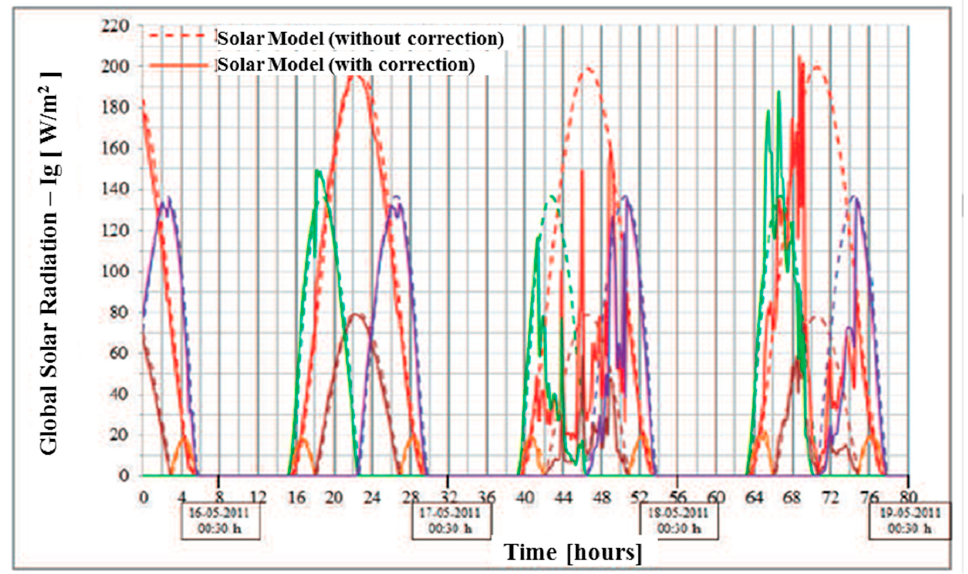
Figure 13. Absorbed radiation, by a white surface ( α s = 0.25), estimated by the solar model for T l = 4.5 and corrected for the observed cloudiness, between 15th and 16th of May.